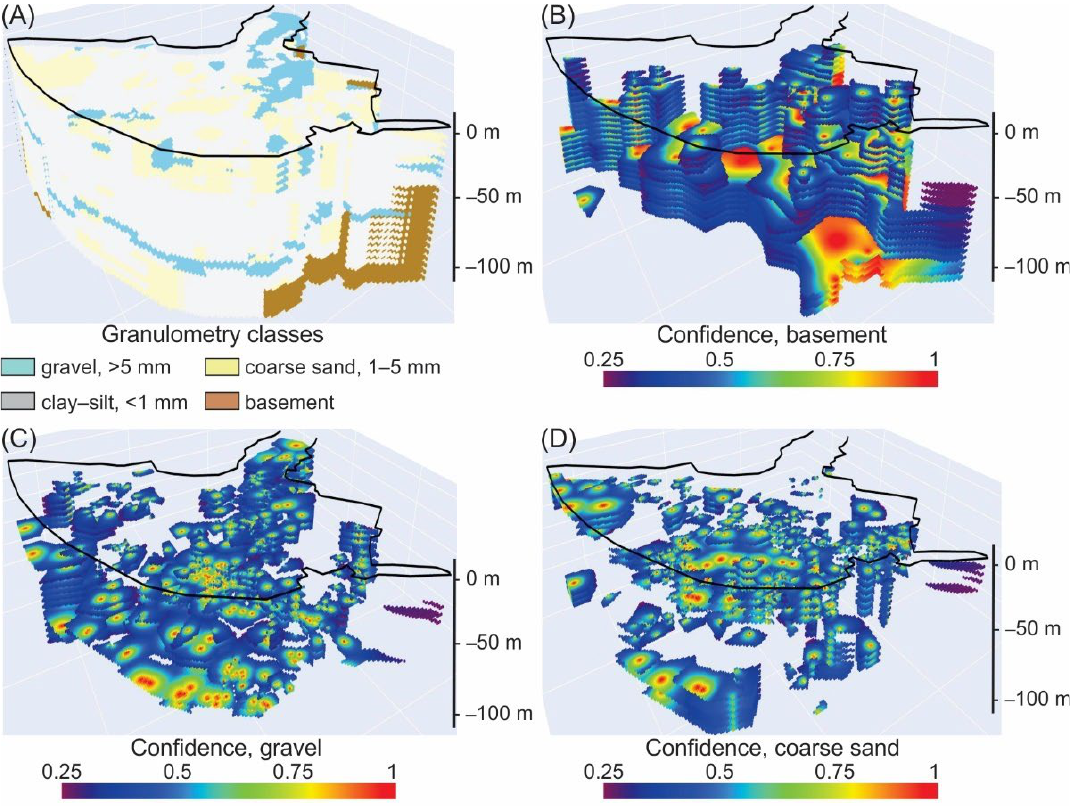
Figure 5. The consecutive horizontal layers (5 m equispaced) of the grain-size (or granulometry) classes generated by the KNN algorithm from 0 to 100 m b.s.l. in the onshore LRD [18] and their corresponding confidences. ( A ) The KNN predictions, with grain-size data classified into the gravel (>5 mm, cyan), coarse sand (1 − 5 mm, yellow), clay–silt (<1 mm, gray) and basement (brown) classes. An interactive 3D version of this model (LRD_Classes_Layers.html) appears in Supplementary Materials. ( B − D ) The corresponding KNN prediction confidences in the 0.25 − 1 range for the basement top surface ( B ) and the secluded areas concerning the gravel ( C ) and coarse sand ( D ) sedimentary bodies (or lithosomes). Interactive 3D versions of the confidence models for the basement top surface (Basement_Confidence_Layers.html), gravel sedimentary bodies (Gravel_Lithosomes_Confidence_Layers.html) and coarse sand sedimentary bodies (Sand_Lithosomes_Confidence_Layers.html) are included in the Supplementary Materials.